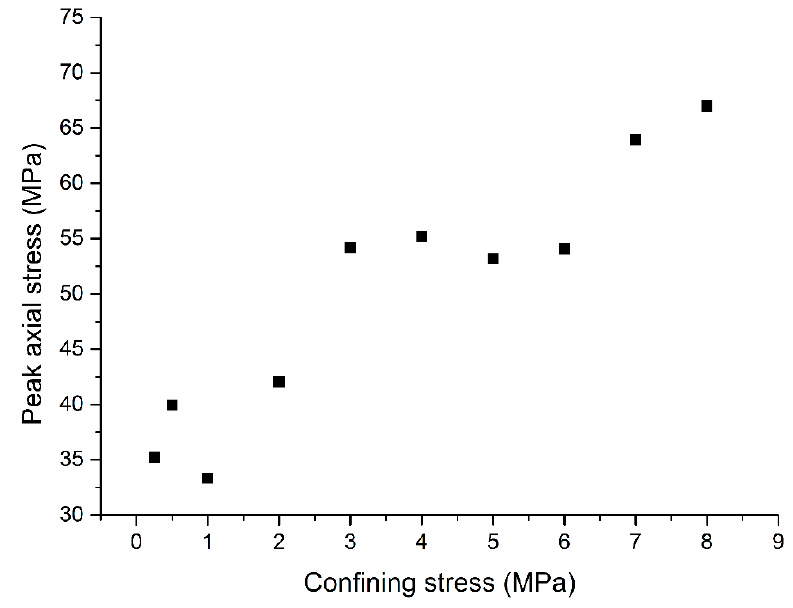
Figure 9. Confinement dependency of peak axial stress for coal specimens of group 1.